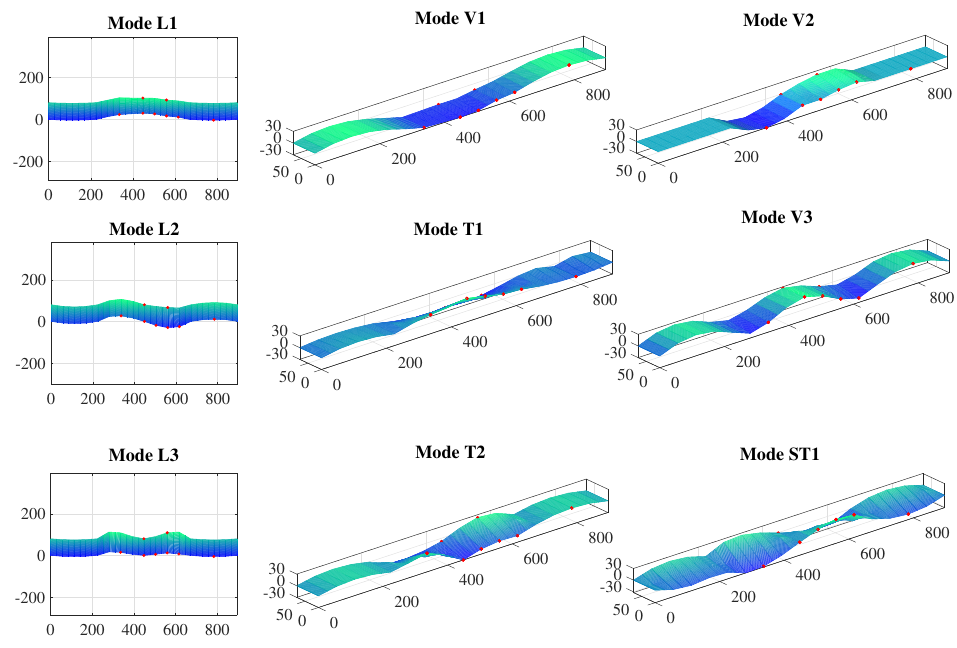
Figure 15. Identified modal